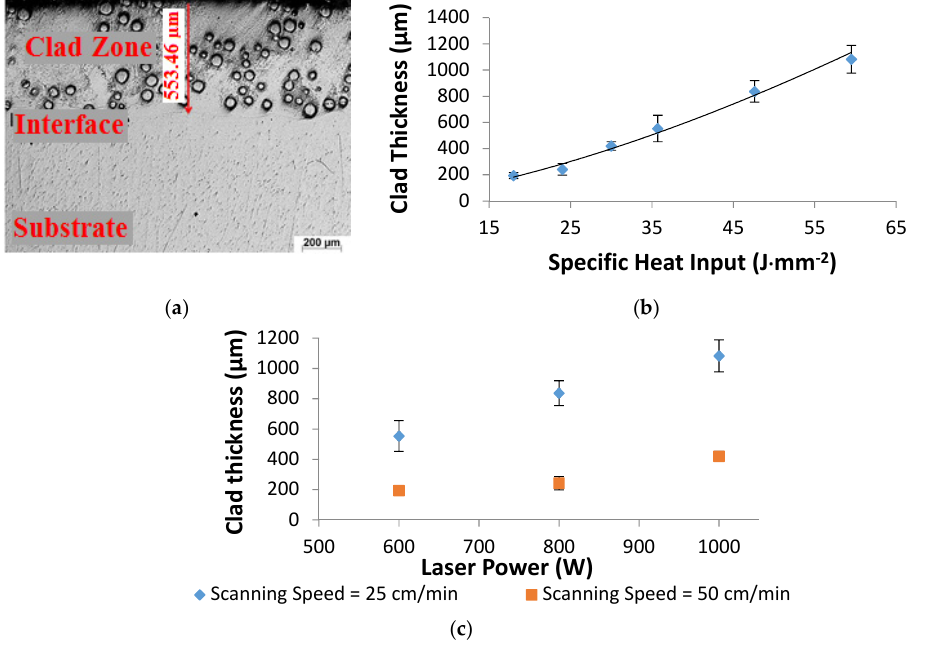
Figure 13. ( a ) Measurement of the clad depth; and the clad depths: ( b ) vs. the specific heat input; and ( c ) vs. laser powers for two laser scanning speeds 25 and 50 cm·min − 1 .